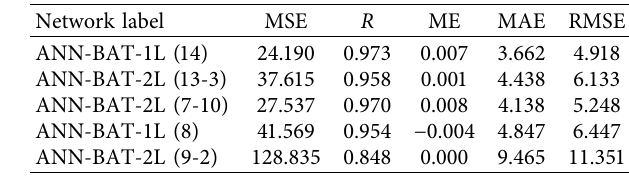
Table 3: Hyperparameters of bat optimization. Table 4: Error metrics of the leading five networks for the training set.